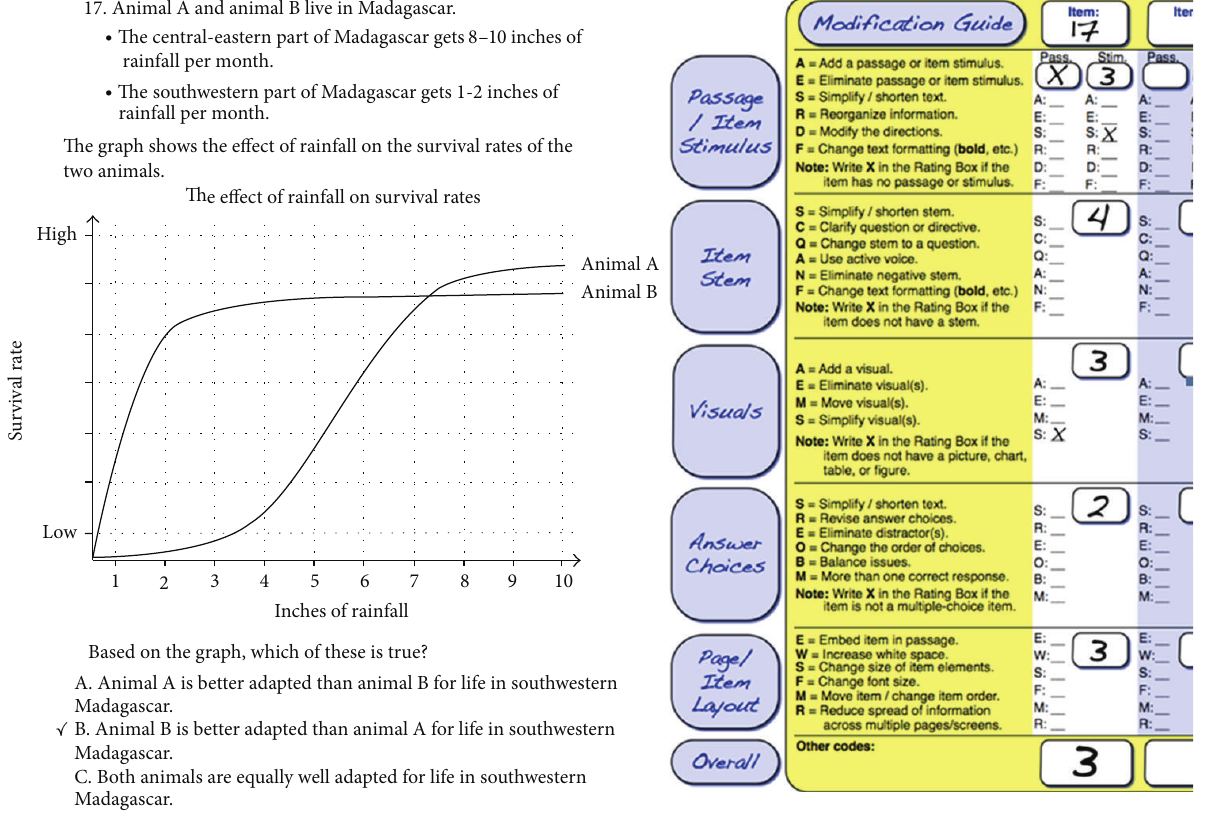
Figure 5: Grade 10 science item with ARM ratings,